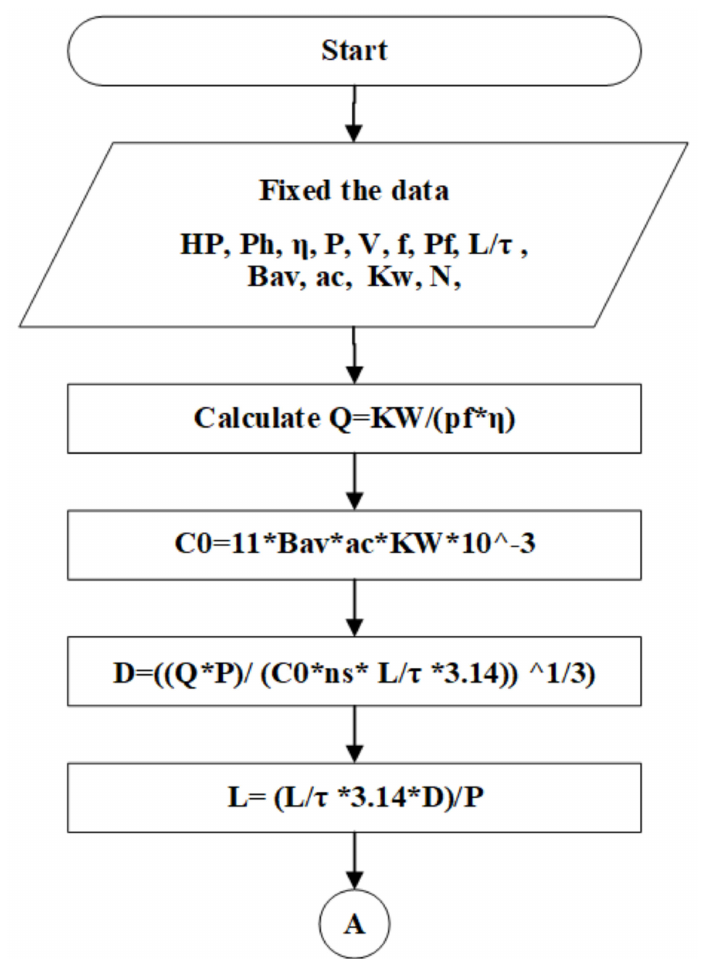
Figure 2. Flowchart for calculation of main stator